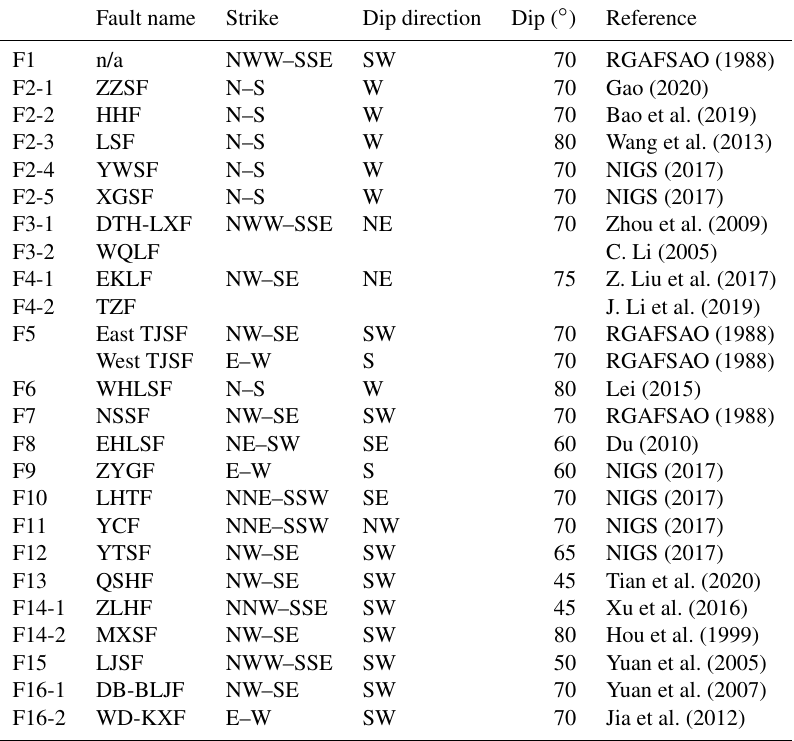
Table 1. Geometric parameters of faults in the model.